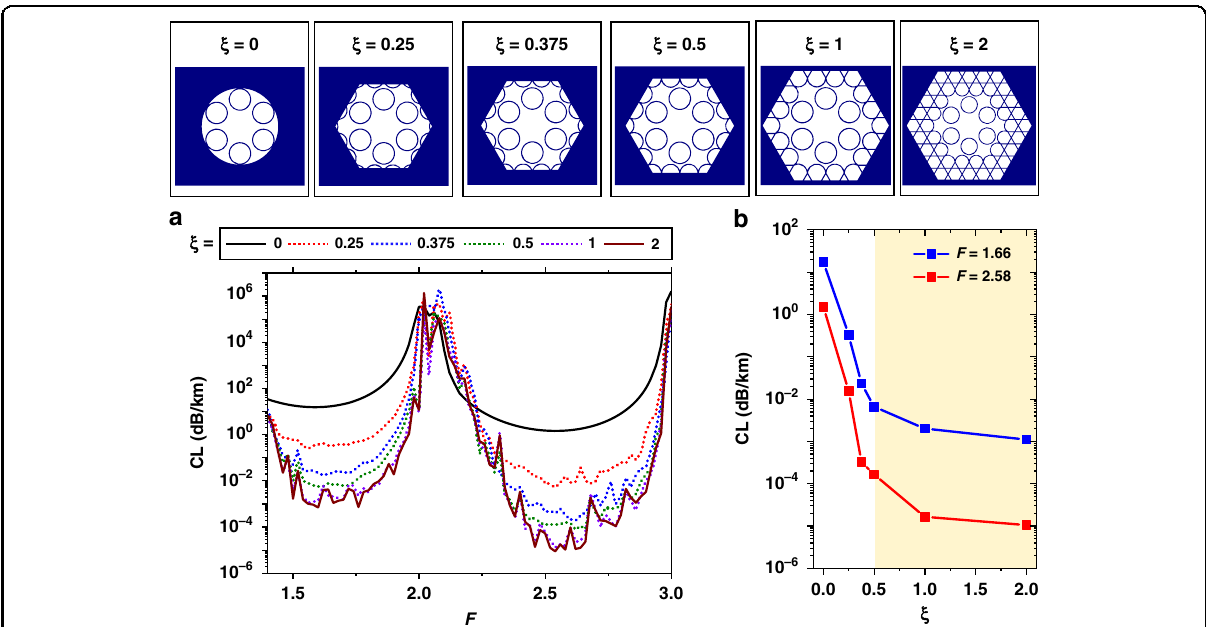
Fig. 2 Study on the effect of adding the Kagome lattice around the tubular lattice in the HKT-HCPCF design. a CL simulation results for fi bre designs with different ξ values (see text for the de fi nition). b CL values for two selected normalised frequency ( F )